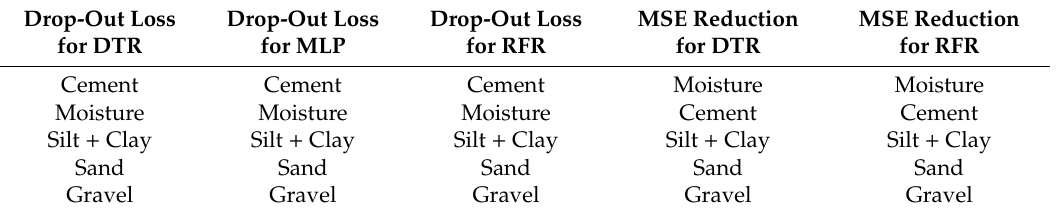
Table 4. Summary of the five rankings (the most important component is at the top of each of the lists).